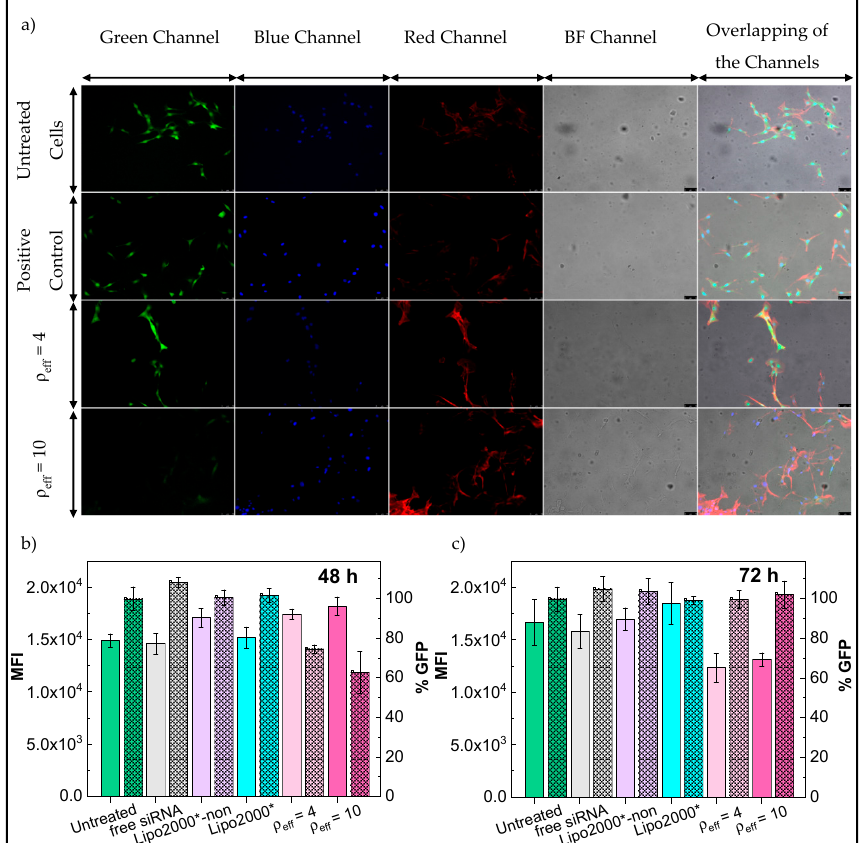
Figure 5. ( a ) Epifluorescence microscopy images for T731-GFP cells treated with C 3 (C 16 His) 2 /MOG-siRNA lipoplexes ( α = 0.2; ρ eff = 4 and 10) and Lipo2000*-antiGFP-siRNA as control, after 72 h of treatment. Images were collected in different channels of fluorescence signals and the overlapping of them. Scale bars are 75 µm. GFP knockdown levels expressed as MFI (unstriped bars, left y-axis) and % GFP (striped bars, right y-axis) in T731-GFP cells at 48 ( b ) and 72 h ( c ) of incubation. Cells treated by the lipoplexes were collected at α = 0.2 and ρ eff = 4 (light pink bars) and 10 (dark pink bars). Untreated cells were used as a reference of the highest MFI and % GFP value. Free siRNA and Lipo2000*-non-targeting siRNA were used as negative controls (gray and purple bars, respectively) while Lipo2000*-antiGFP-siRNA was used as positive control (blue bars). All experiments were performed with 10% ( v/v ) of HS. The data represent the mean ± SD of three independent wells.